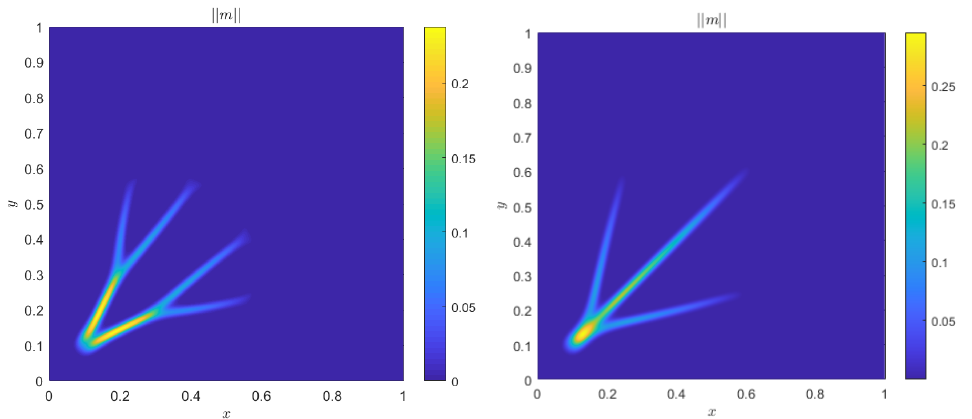
Figure 8. In this figure, we show the steady states when γ = 0.75 < 1. On the left, the initial condition is m 0 = m 0,1 = 1 while on the right, the initial condition is a function of space, m 0 = m 0,3 , and the parameters are defined in T EST